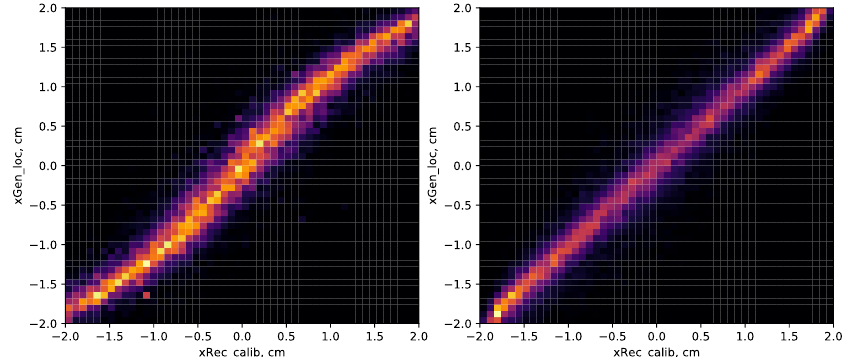
Figure 2. S-curve calibration results for inner modules and local coordinate x using parametric approach (left) and XGBoost regressor